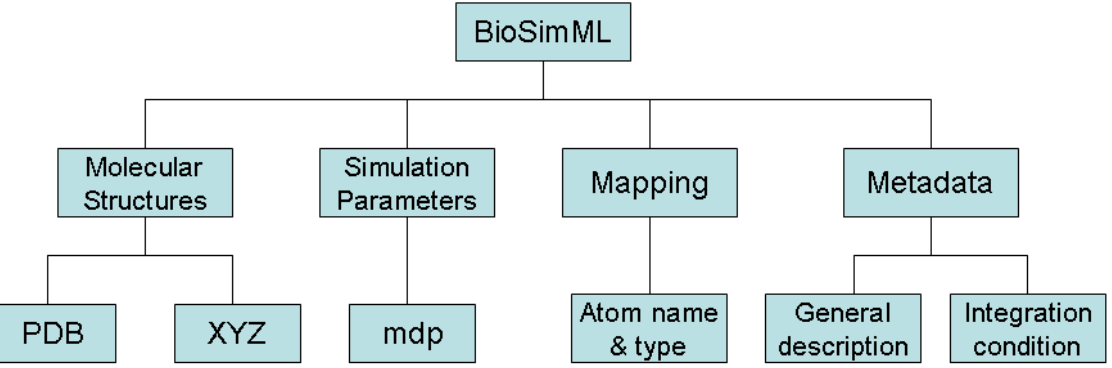
Figure 1: The structure of BioSimML markup